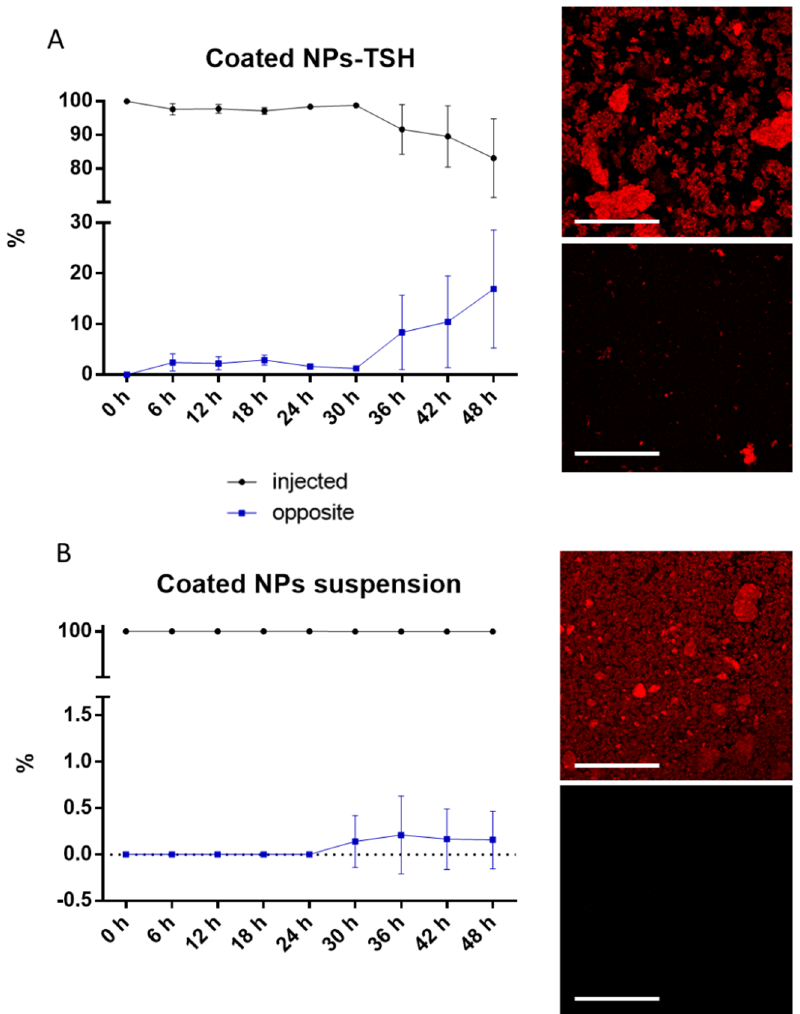
Figure 5. Fluorescence intensity% of NPs after administration in synthetic vitreous with representative confocal images at 48 h. Black line: fluorescence intensity at the injected site. Blue line: fluorescence intensity at the opposite corner. ( A ) Mobility of HA12-coated NPs in the TSH formulation. ( B ) Mobility of HA12-coated NPs in water suspension. Mean and SD, n = 3. Scale bar: 100 µm.